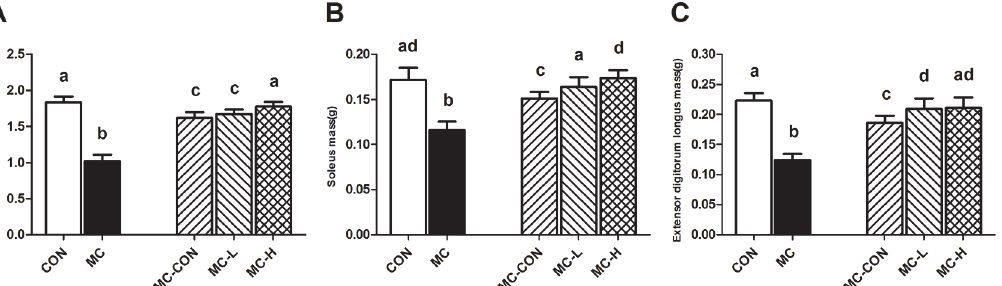
Fig 2. Comparison of Skeletal Muscle Masses. Wet masses of the gastrocnemius (A), soleus (B), and extensor digitorum longus (C) were measured for each group at the study end point. Values are presented as means ± standard deviation (SD). Different letters indicate a significant difference (p <